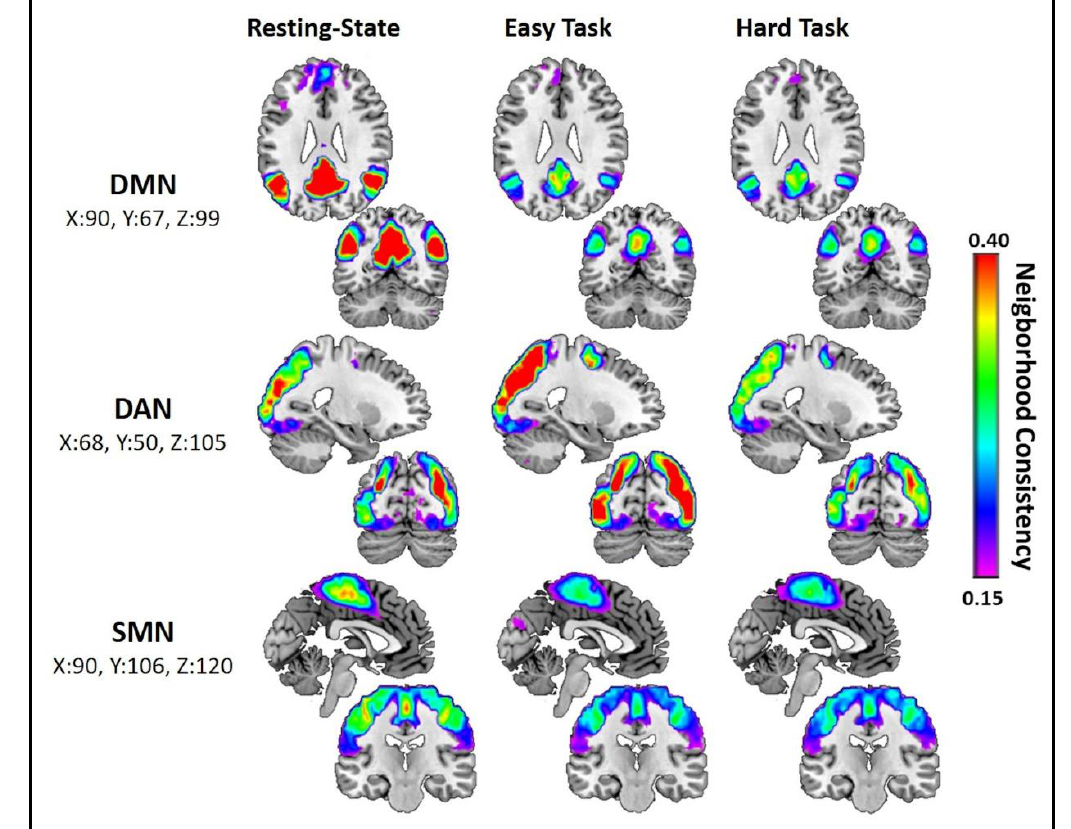
Figure 3. Cool colors indicate a less consistent network community structure than warm colors. The dorsal attention network (DAN) is more consistent during the MI tasks, particularly the Easy Task, than the Resting state. The default mode network (DMN) is most consistent during the Resting state and shows a sharp decline during the MI tasks. The sensorimotor network (SMN) is also more consistent during the Resting state than during MI tasks.